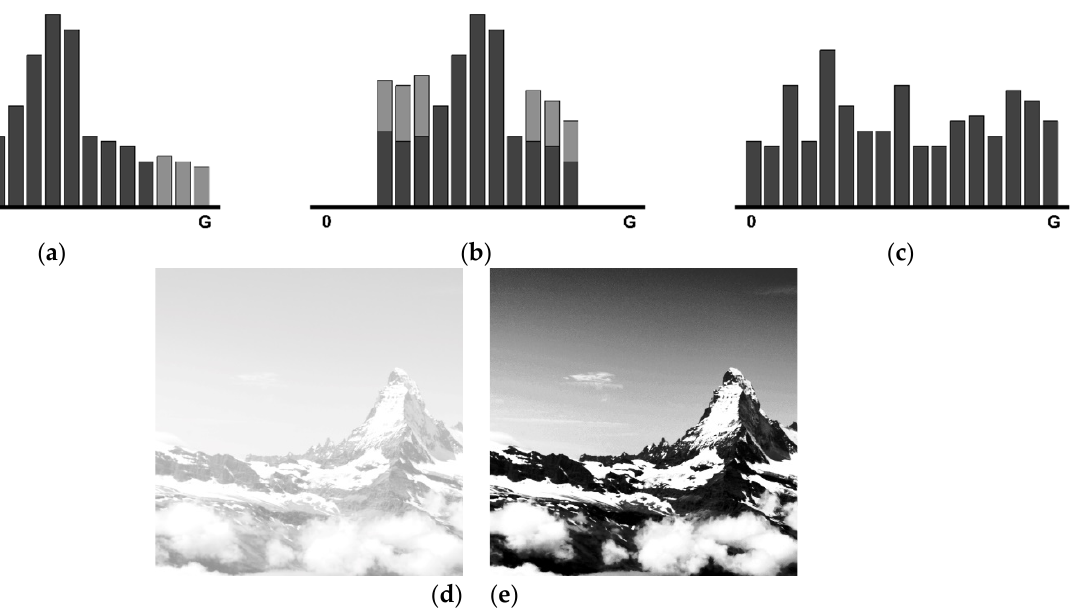
Figure 2. Representation of the ( a ) original, ( b ) preprocessed, ( c ) final histograms. ( d ) Original, and ( e ) contrasted images.[25].